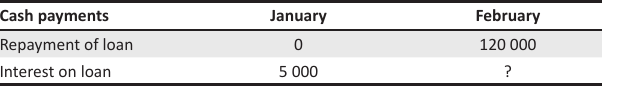
TABLE 4: Extract from Cash budget of Edgewood Ltd for January and February 2012.